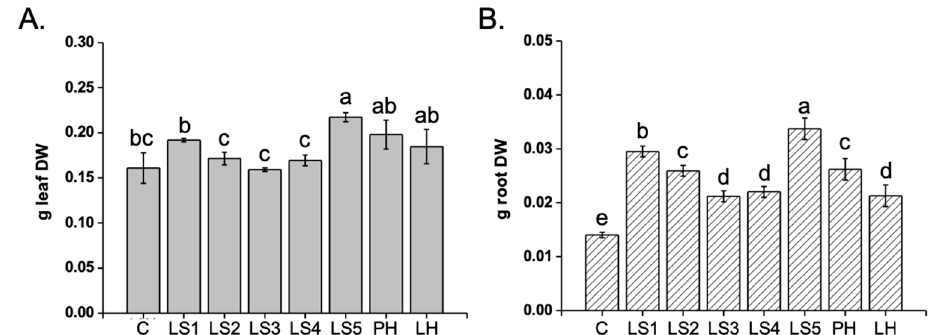
Figure 3. E ff ect of individual humates (Hs) on leaf ( A ) and root ( B ) dry weight of Z. mays L. plants. Twelve-day-old plants were supplied for two days with Hs at 1 mg C L − 1 . Di ff erent letters above bars indicate significant di ff erences at p < 0.05, according to the Student–Newman–Keuls test. Data represent the means of three measurements with ten plants in each ( ± SD). C = control; LH = commercial lignosulfonate-based product; PH = commercial humate extracted from leonardite; LS1 − LS5 = specialty